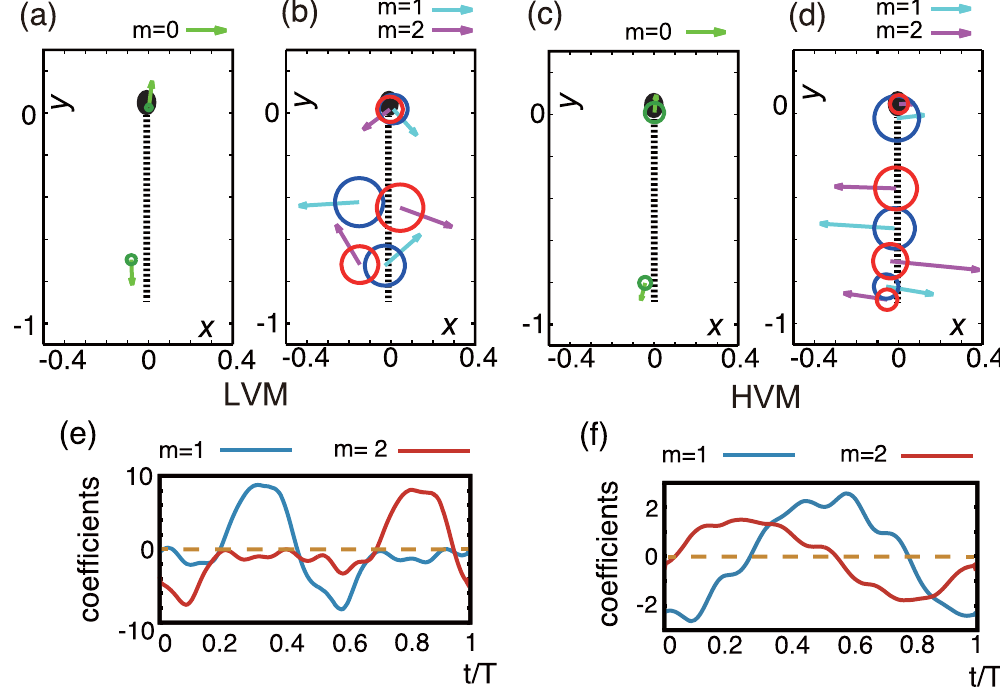
Figure 2. The regularised Stokeslet representation for a swimming human sperm in a low viscosity, watery Newtonian medium (LVM, ( a , b )) and a highly-viscous, weakly elastic, 1% methylcellulose solution (HVM, ( c , d )), with axes labels in units of flagellum length. The regularised Stokeslet representations for the time- averaged flow field (( a , c ), m = 0) and for the lowest two flow bases (( b , d ), m ∈ {1, 2}) are shown. The origin, length and direction of the arrows give the location, magnitude and direction of the force singularities, and the circle radius corresponds to the regularised parameter. The dashed lines show the centreline of the model sperm, while the black ellipse shows the location of the sperm head for illustration. The time dependent weightings for modes 1, 2 for LVM are plotted for time t over a flagellum beat pattern period, T , in ( e ) with analogous plots for HVM in plot ( f ). Note that modes 1, 2 are out of phase so that the regularised singularities in plots ( b , d ) do not simply undergo constructive or destructive interference. The data used to generate plots ( b , d , e , f ) may be found in 35,36 , together with further details on the derivation of the